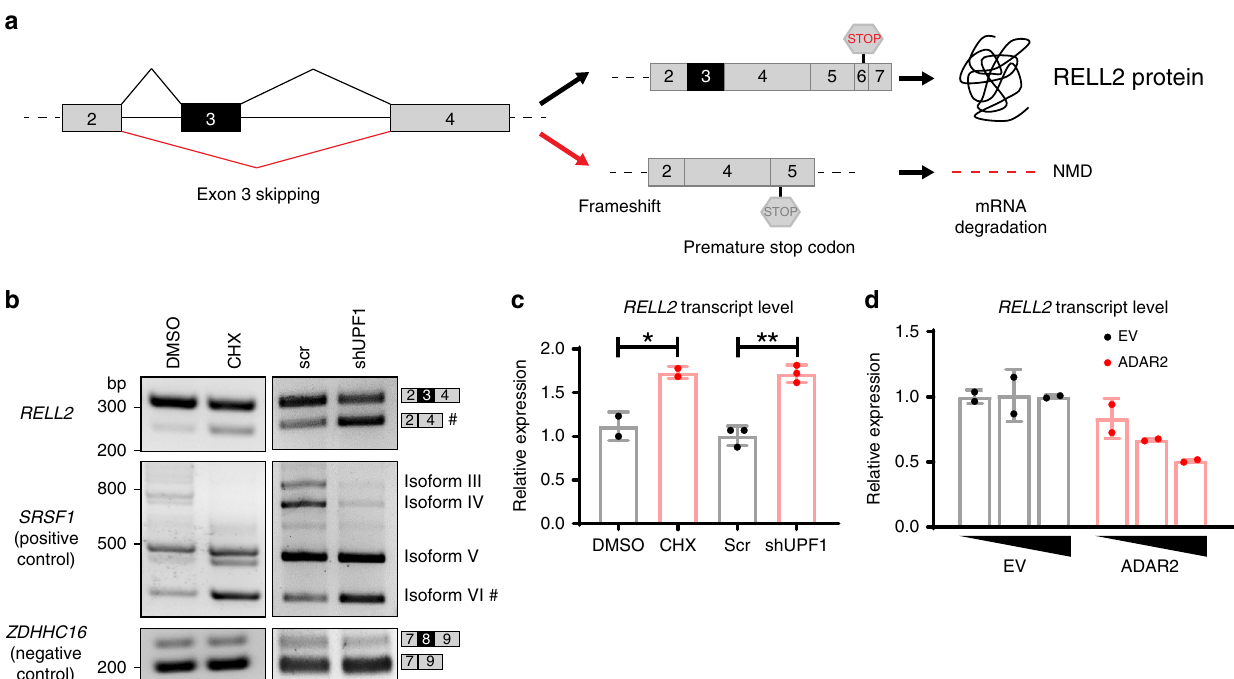
Fig. 7 Skipping of RELL2 exon 3 results in AS-NMD. a Schematic diagram showing skipping of RELL2 exon 3 may trigger NMD. With exon 3 included, RELL2 pre-mRNA has a stop codon at the end of exon 6, which is then translated to a functional protein. In contrast, skipping of exon 3 results in a frameshift and creates a pre-mature termination codon at the beginning of exon 5, which locates 368 nt upstream of the last exon – exon junction. b RT-PCR analysis of different isoforms of the indicated transcripts in HEK293T cells upon inhibition of NMD. Cells were transfected with scramble shRNA (scr) or shRNA against UPF1 (sh UPF1 ) for UPF1 knockdown, or treated with DMSO or CHX. SRSF1 or ZDHHC16 serves as a positive or negative control, respectively, to ensure successful inhibition of NMD. Number sign indicates the NMD-sensitive isoform. c qPCR analysis of total RELL2 transcript level in HEK293T cells with the indicated treatment. Data are presented as the mean ± S.D. of relative expression derived from qPCR technical triplicates or duplicates from a representative experiment. Each dot represents a technical replicate. Statistical signi fi cance is determined by unpaired, two-tailed Student ’ s t -test (* P < 0.05; ** P < 0.01). d qPCR analysis of total RELL2 transcript level in HEK293T cells that were transfected with the increasing amount of EV (empty vector) or ADAR2 construct. Data are presented as the mean ± S.D. of relative expression derived from qPCR technical duplicates from a representative experiment. Each dot represents a technical replicate. Source data are provided as a Source Data fi